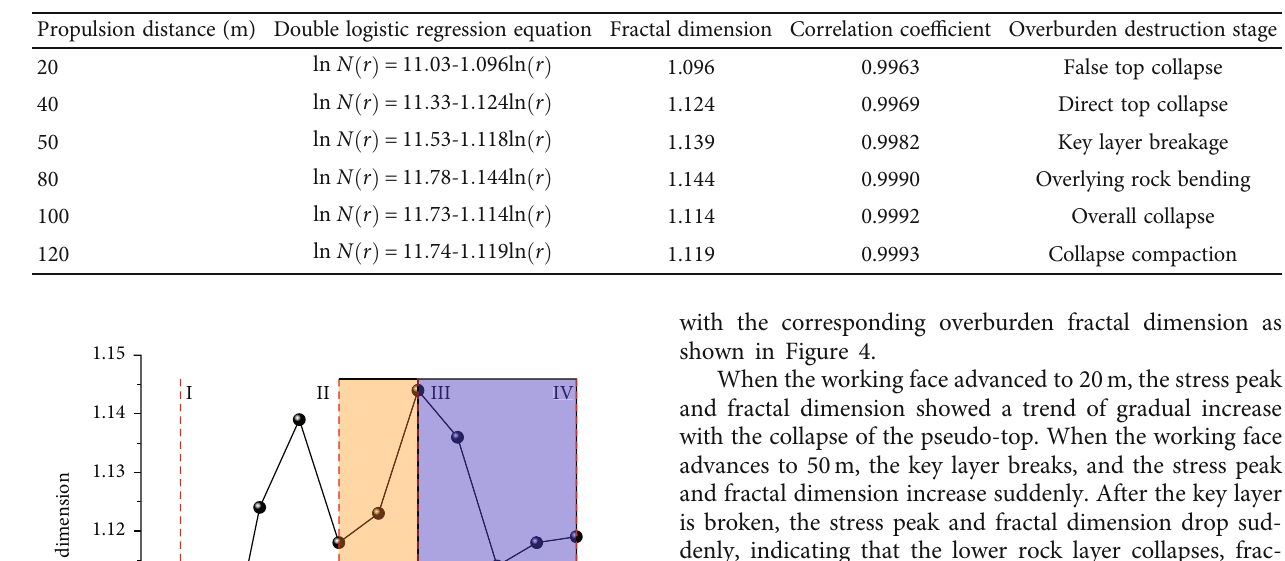
Table 3: Relationships between fractal dimension and overburden deformation and damage.